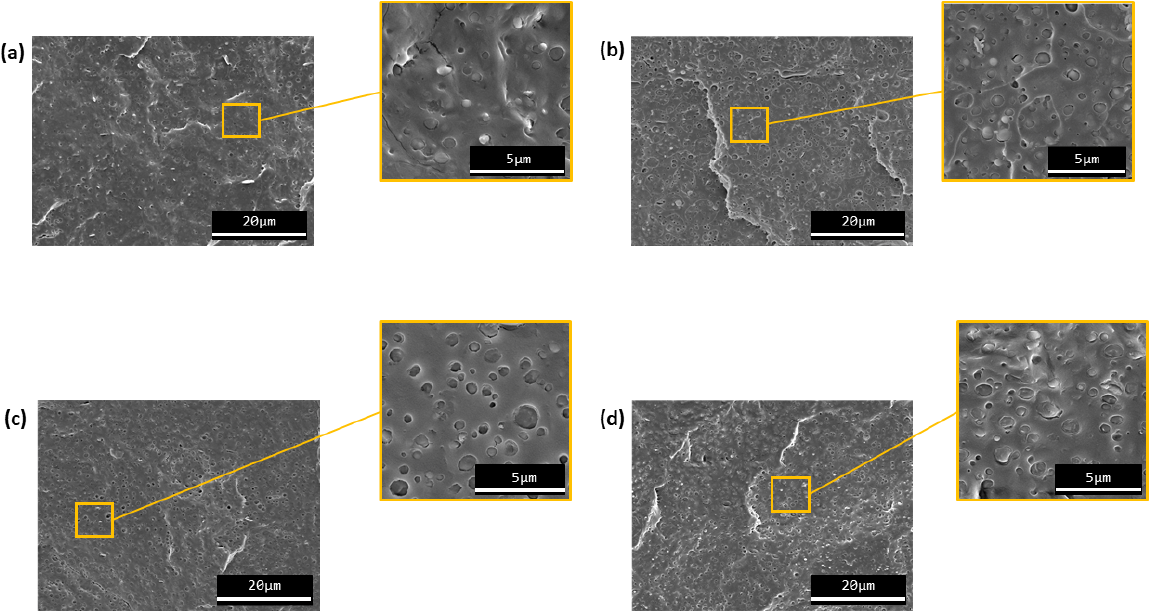
Figure 10. SEM micrographs of ( a ) PHB30, ( b ) PHB30-Joncryl ® , ( c ) PHB30-TGIC, and ( d ) PHB30- polyHMDI .